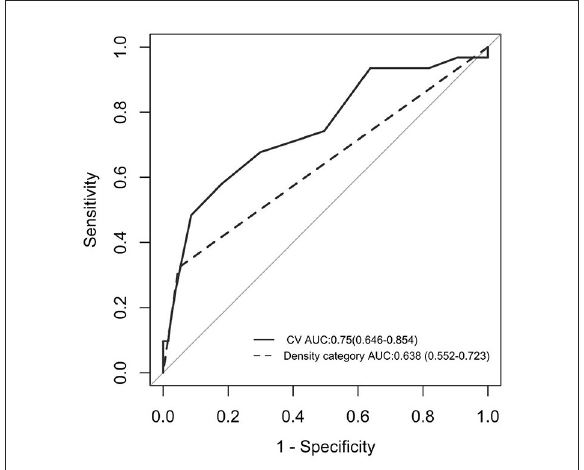
FIGURE3 ROC curve analysis between the CV of hematoma HU and early hematoma growth. AUC was 0.750, and the cutoff point was 18% (solid line). ROC curve analysis between “heterogeneous” in the density category and early hematoma growth. AUC was 0.638 (dotted line). AUC, area under the curve; ROC curve, receiver operating characteristic curve; HU, Hounsfield unit; CV, coefficient of